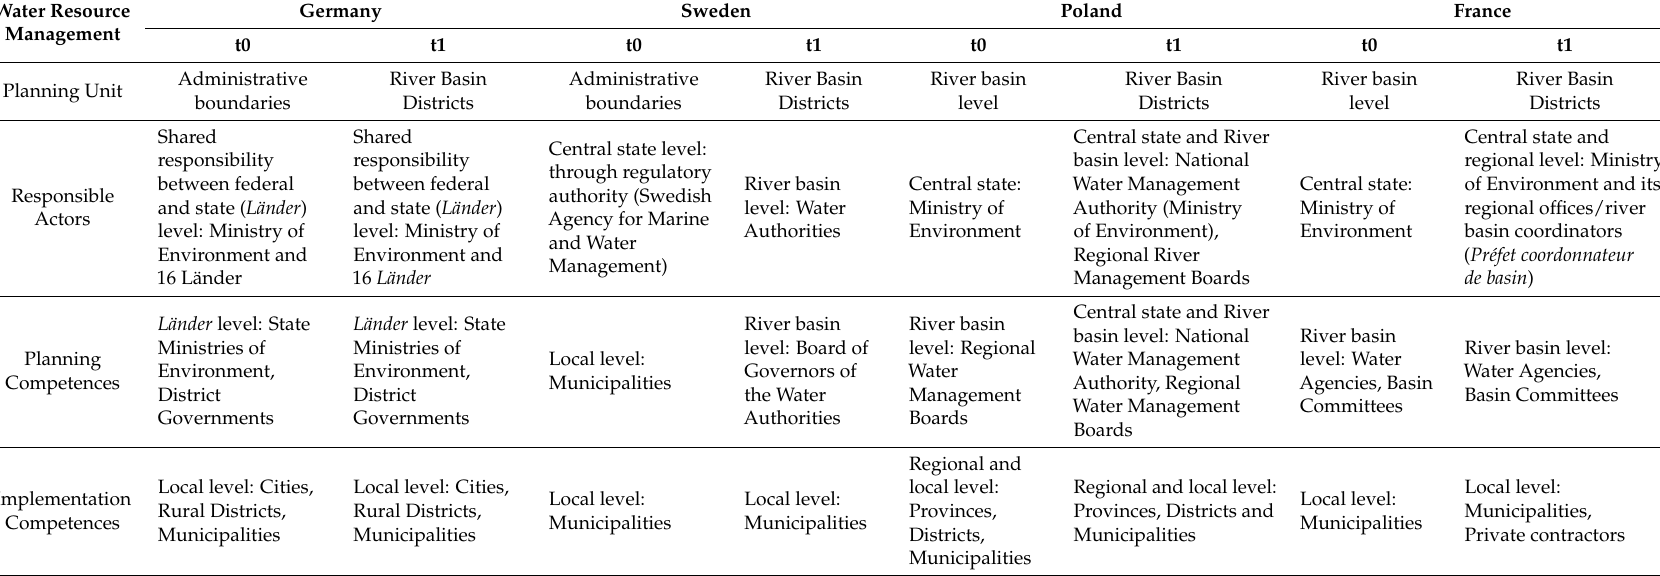
Table A1. Institutional Arrangements for Water Resources Management and Participation before (t0) and after (t1) the WFD in Four Member States. Water Resource